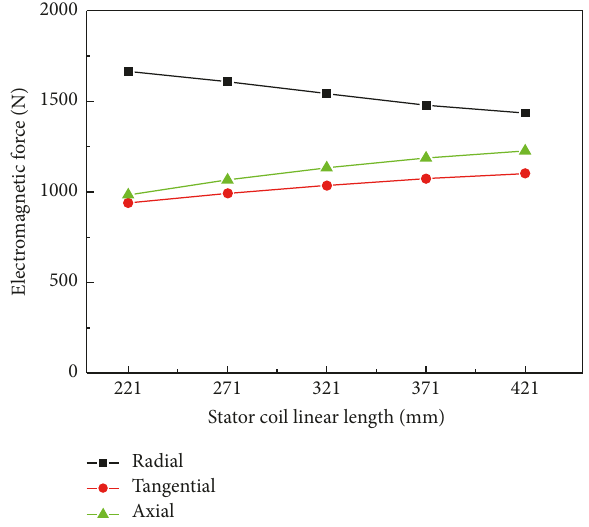
Figure 15: Electromagnetic force density distribution on the involute part at 0.039 s, when 𝑙 𝑙 = 421mm (top). (a) Radial component. (b) Tangential component. (c) Axial component. sc